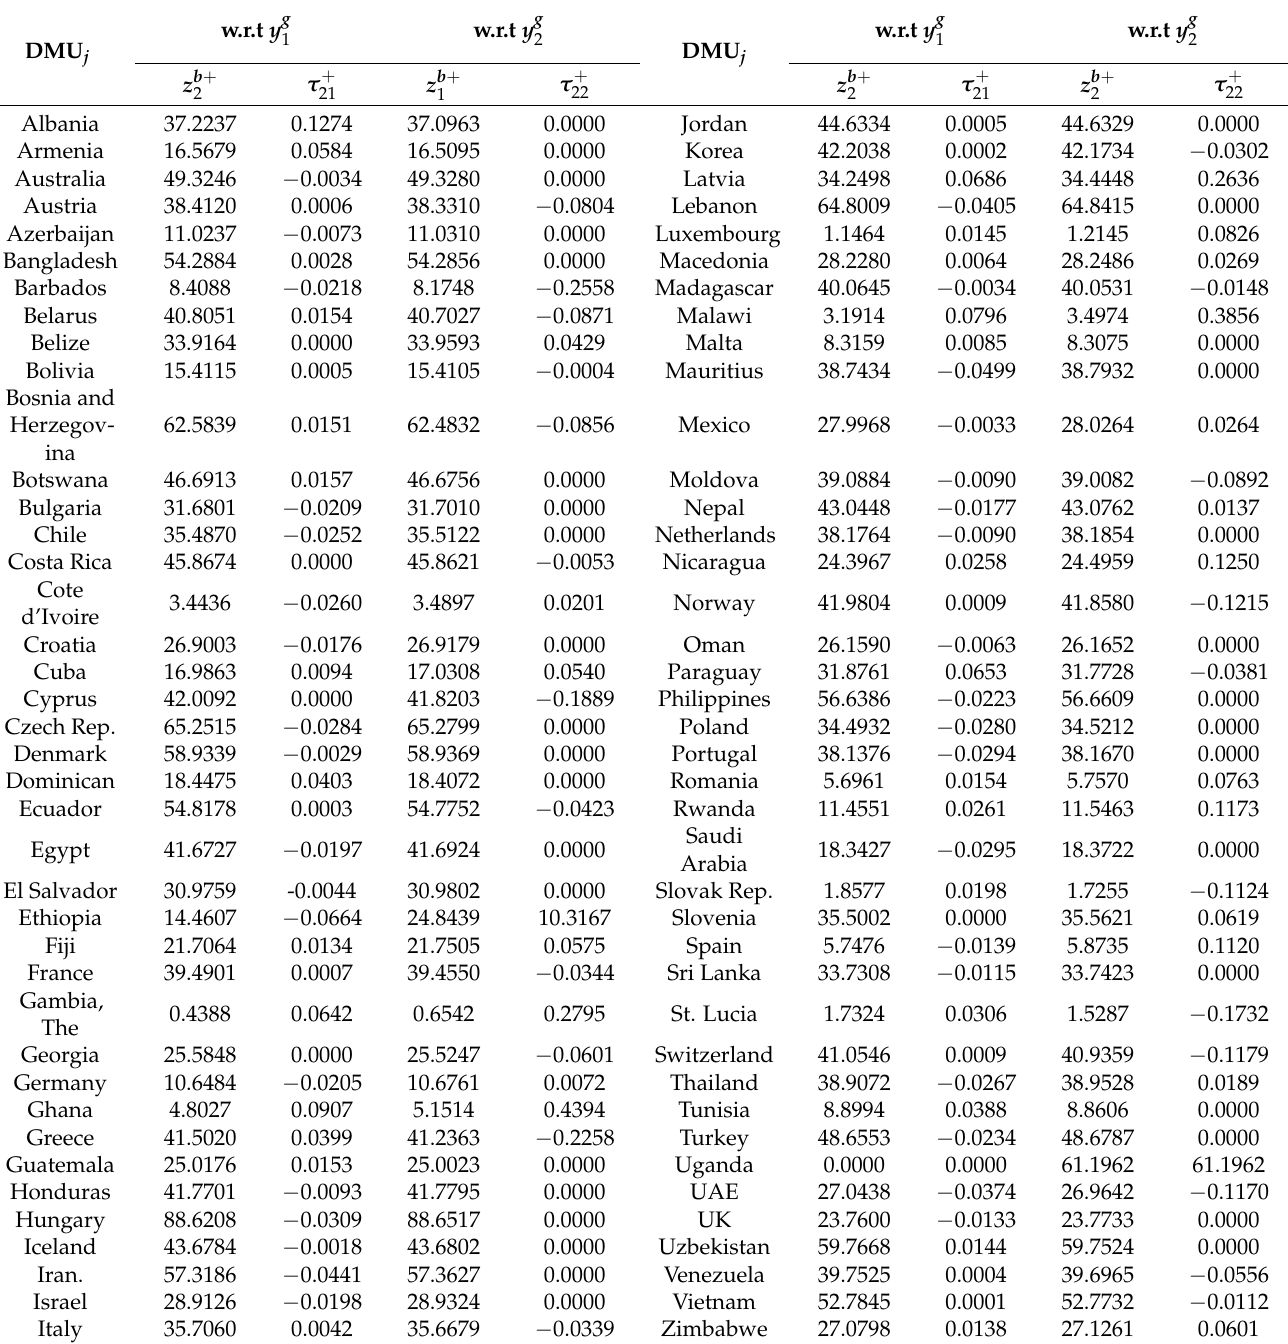
) when h = +0.5 and d = (1, 2